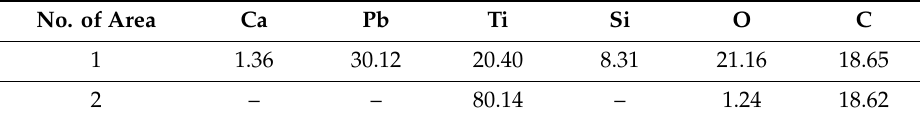
Table 2. The elemental composition of areas 1 and 2 in Figure 5a (at.%).